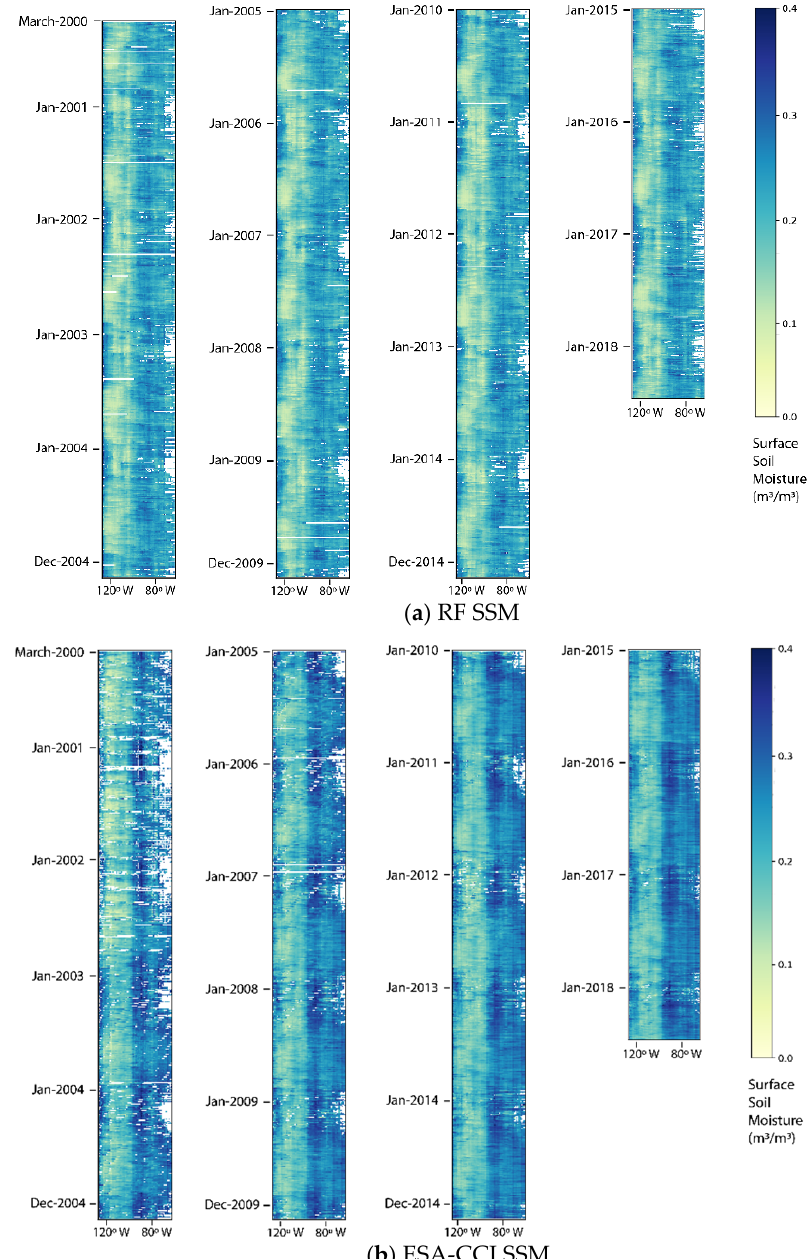
Figure 9. Time-longitude diagram over the continental U.S.